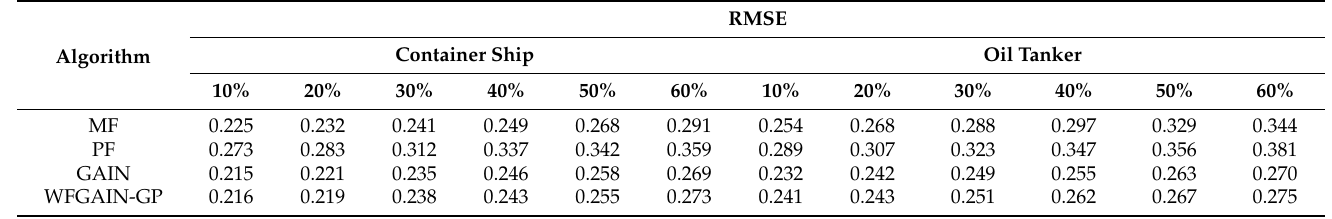
Table A4. RMSE values of imputation results of each model for container ship and tanker data with different missing rates.